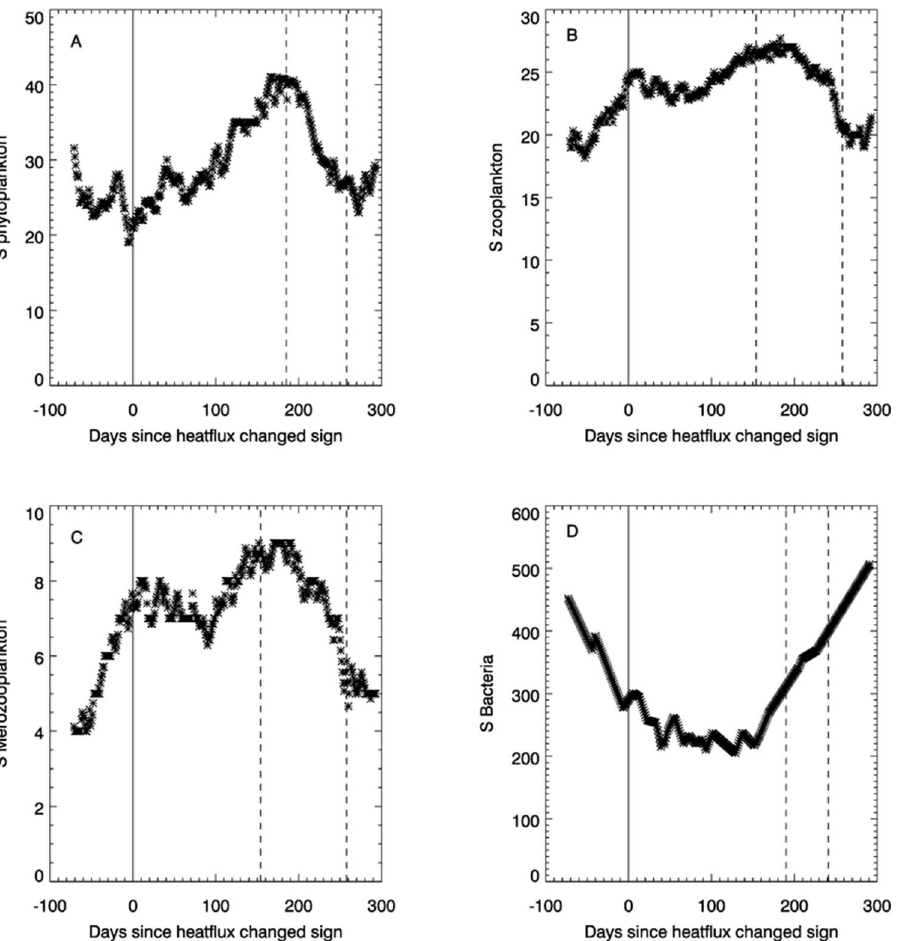
Figure 2. Median filtered daily interpolated biodiversity ( species richness –S ) data for ( A ) phytoplankton; ( B ) zooplankton; ( C ) merozooplankton and ( D ) bacteria relative to the change in sign for the NHF. The switch to negative heat flux (relative to the switch to positive and shown as the minimum and maximum range) is shown later in the season around 185–260 days afterwards, represented by the pair of dashed